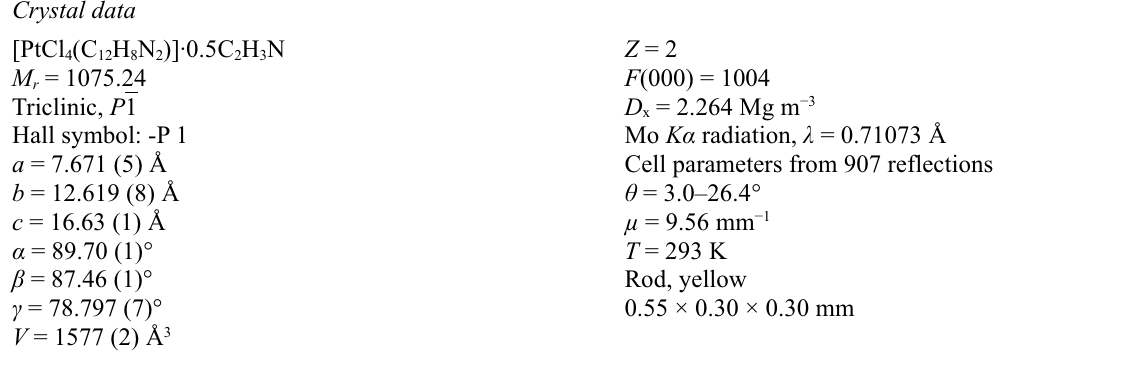
View of the unit-cell contents of the title compound. Hydrogen-bond interactions are drawn with dashed lines. Tetrachlorido(1,10-phenanthroline- κ 2 N , N ′ )platinum(IV) acetonitrile